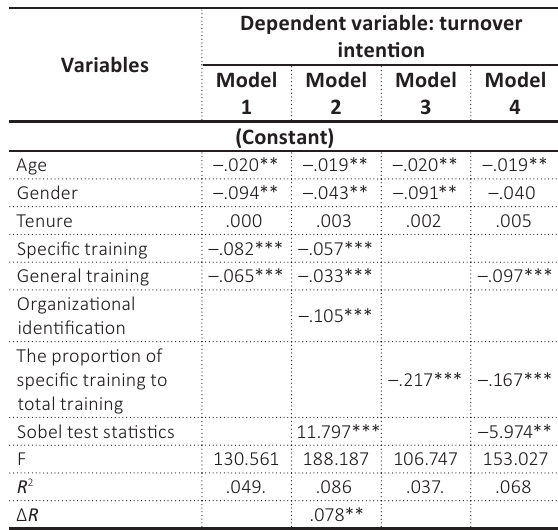
Table 2. Results of regression analysis of turnover